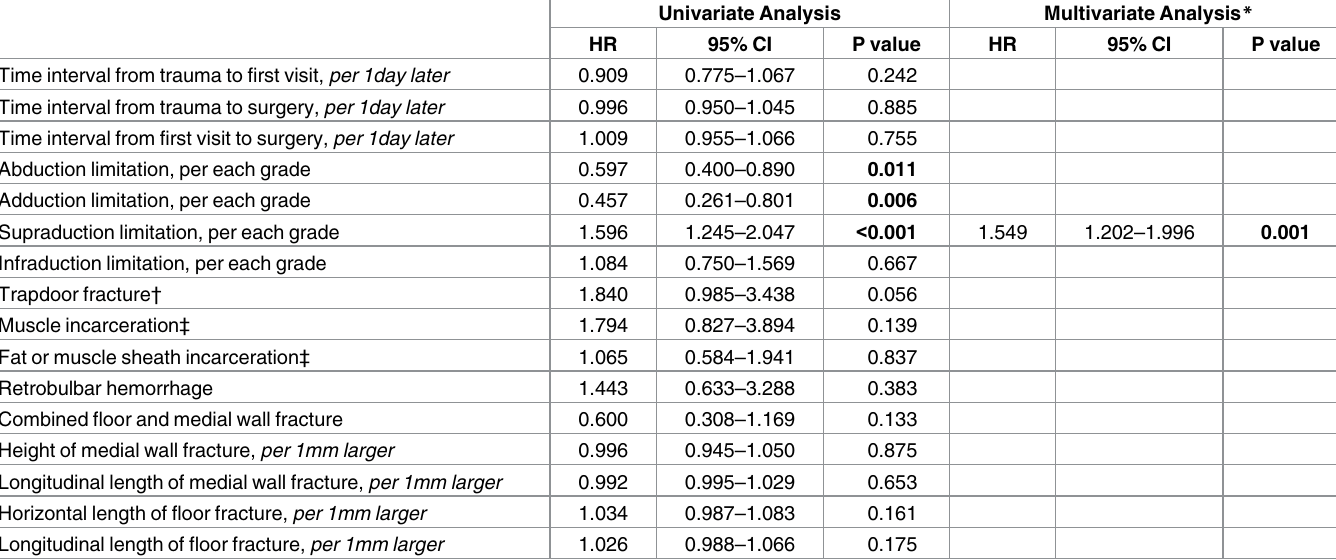
Table 4. Factors associated with resolution of central diplopia within 30 degree.